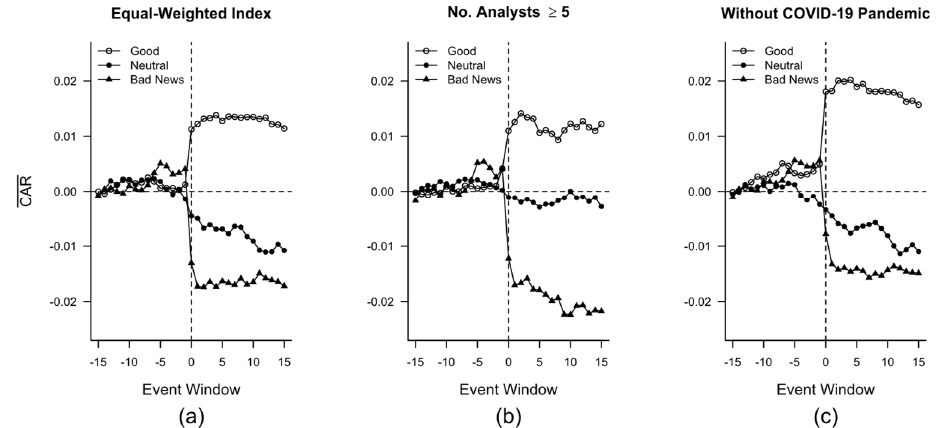
Figure 4. Different analyses for robustness checks: ( a ) Analysis over the whole sample period with an equal-weighted index of all stocks in the study for the market return; ( b ) Analysis over the whole sample period using only event with at least five earnings forecasts from analysts; ( c ) Analysis for the sub-sample containing only events until the end of